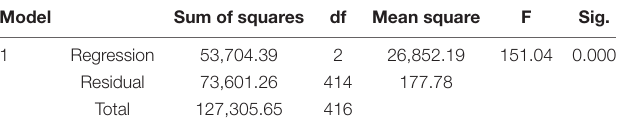
TABLE 5 | ANOVA for psychological well-being, loving pedagogy, work engagement. Model